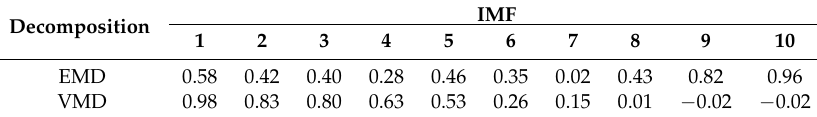
Table 1. Correlation index comparison of EMD and VMD.